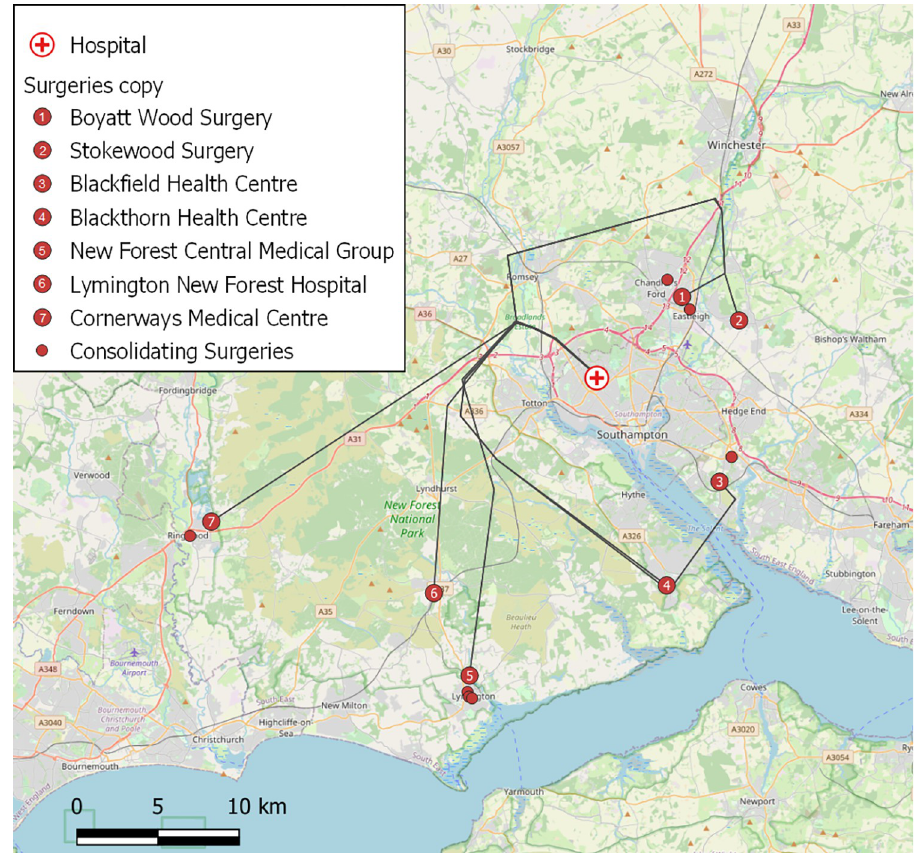
Fig 9. Locations of Doctors’ surgeries included in the investigation. Grey lines indicate UAV flightpaths. Base map and data from OpenStreetMap and OpenStreetMap